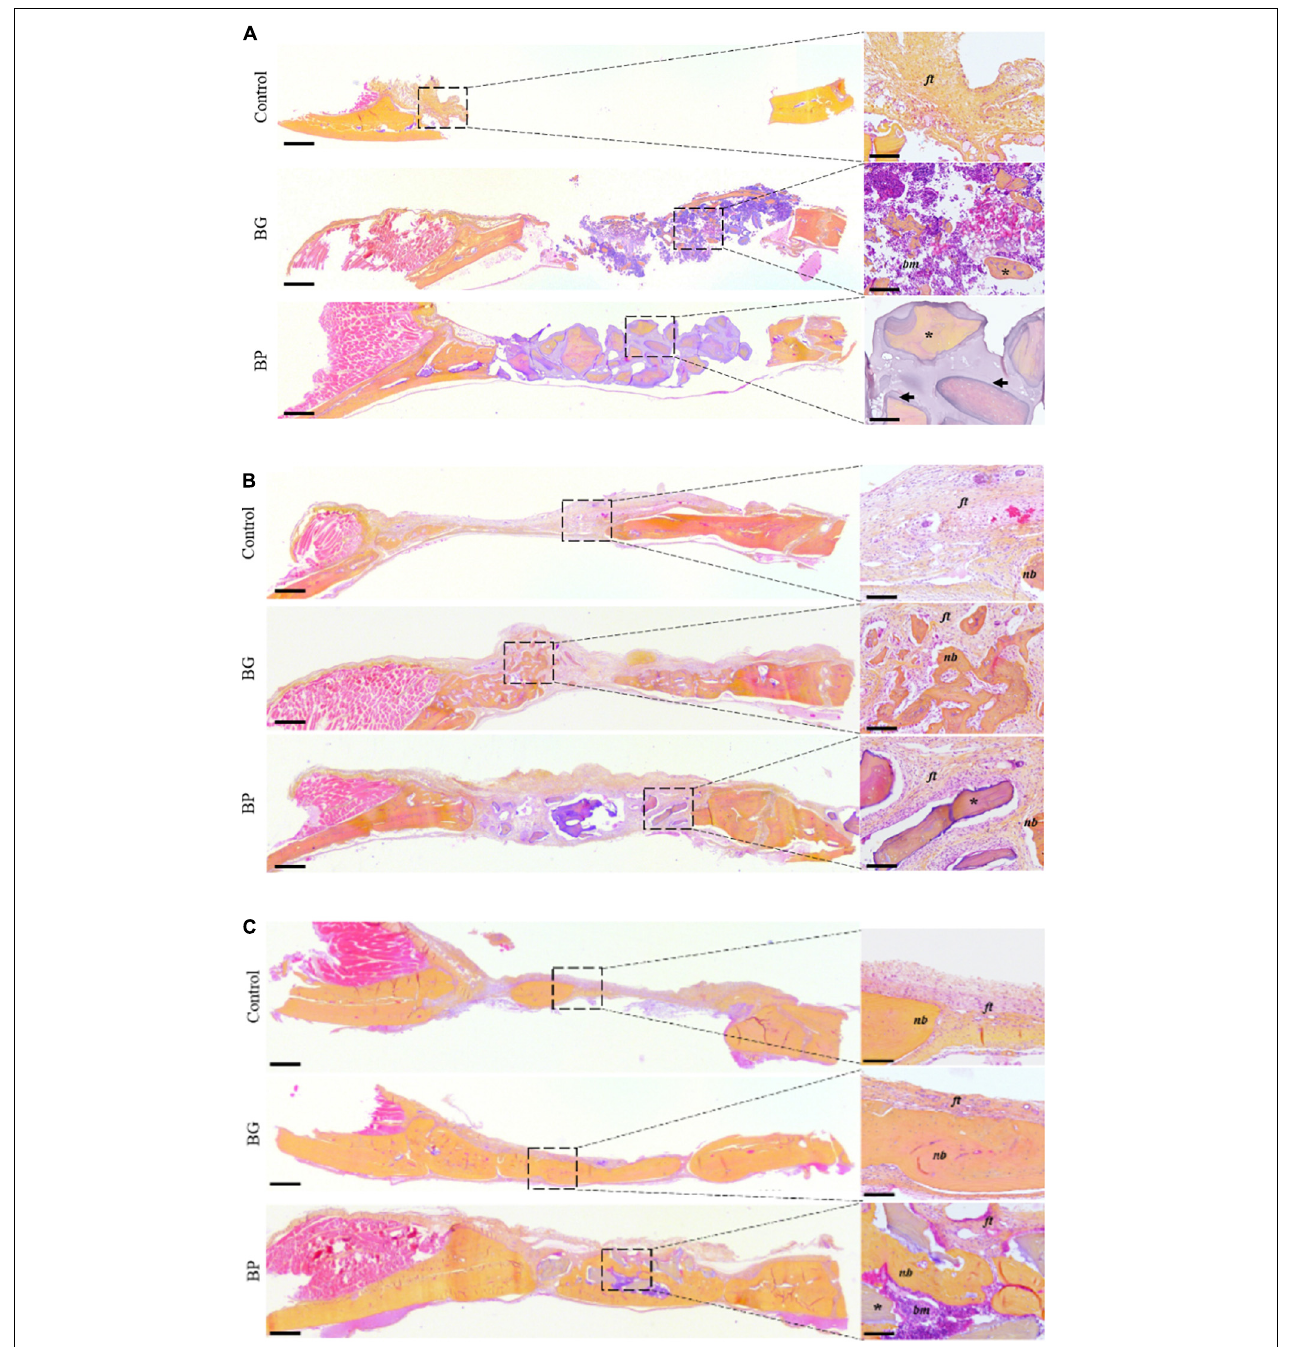
FIGURE 3 | Histological observation of the bone regeneration in a critical-size defect model in rat calvaria. Representative images of the defects by HES staining of decalcified 5 µ m-thick frontal sections of the defects after surgery (A) T0, (B) 3 weeks, and (C) 7 weeks. The defects were left unfilled (controls), filled with a syngeneic bone graft (BG), or filled with the bone paste (BP). Scale bars: 500 µ m for the full defects, 100 µ m for the enlarged sections (dashed square). Dark arrows: demineralized bone matrix, dark yellow: collagen-rich bone tissue, light red: cell cytoplasm, purple/blue: nuclei, ft , fibrous tissue; nb , new bone; *, bone grafts; bm , bone